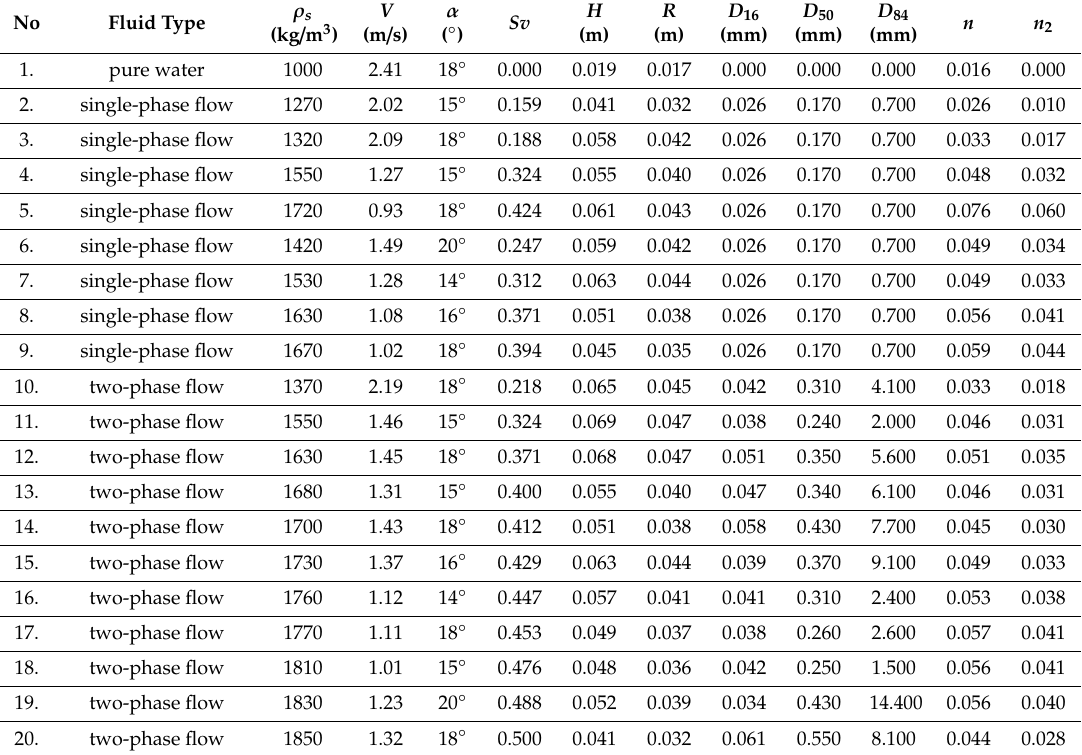
Table 1. Experimental conditions and preliminary experimental